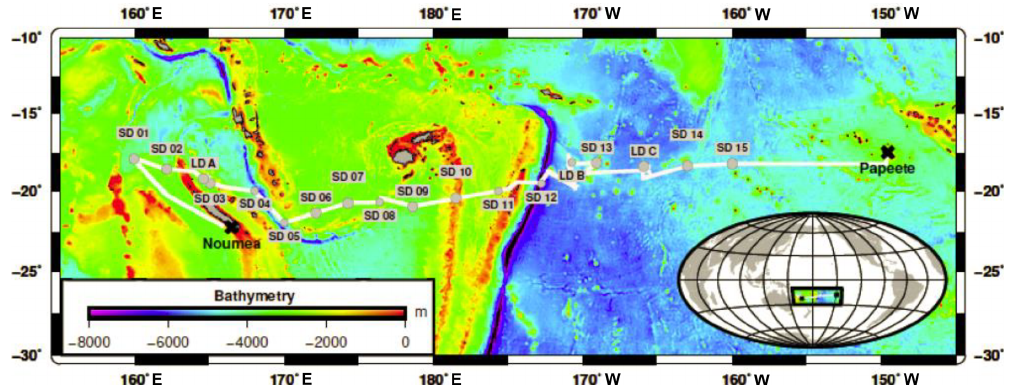
Figure 1. Sampling stations during the OUTPACE cruise. The white line shows the vessel course (data from the hull-mounted ADCP positioning system). Stations and their respective names (SD1-SD15 including LDA, LDB and LDC) are depicted in grey. Figure courtesy of Thibault